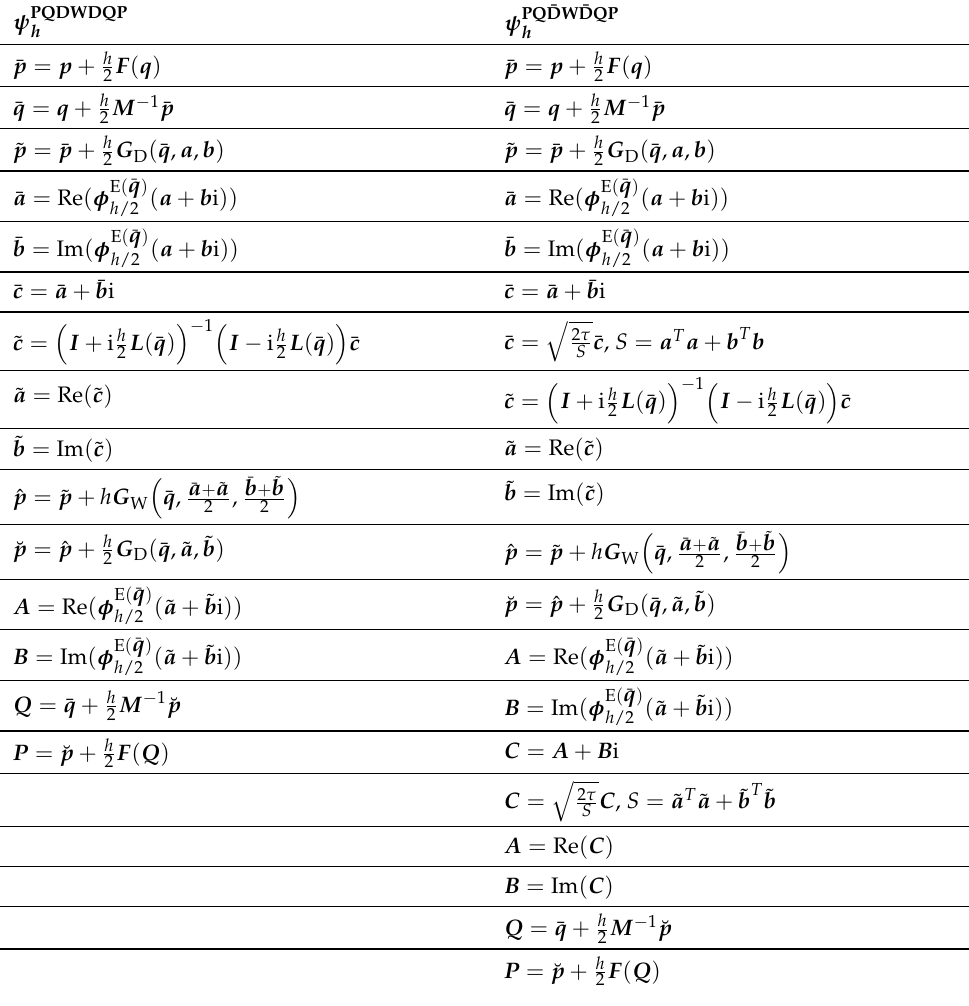
Table A3. Explicit representations of semi-implicit numerical flow maps ψ PQDWDQP ψ QPDWDPQ